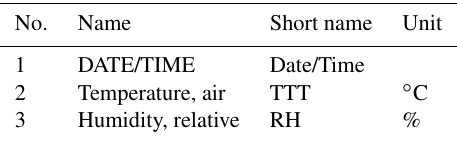
Table 9. Structure of temperature and relative-humidity data sets at PANGEA (Nield et al., 2020a). Data are taken at the ridges and polygon centres of three sites every 2min from 25 November to 2 December